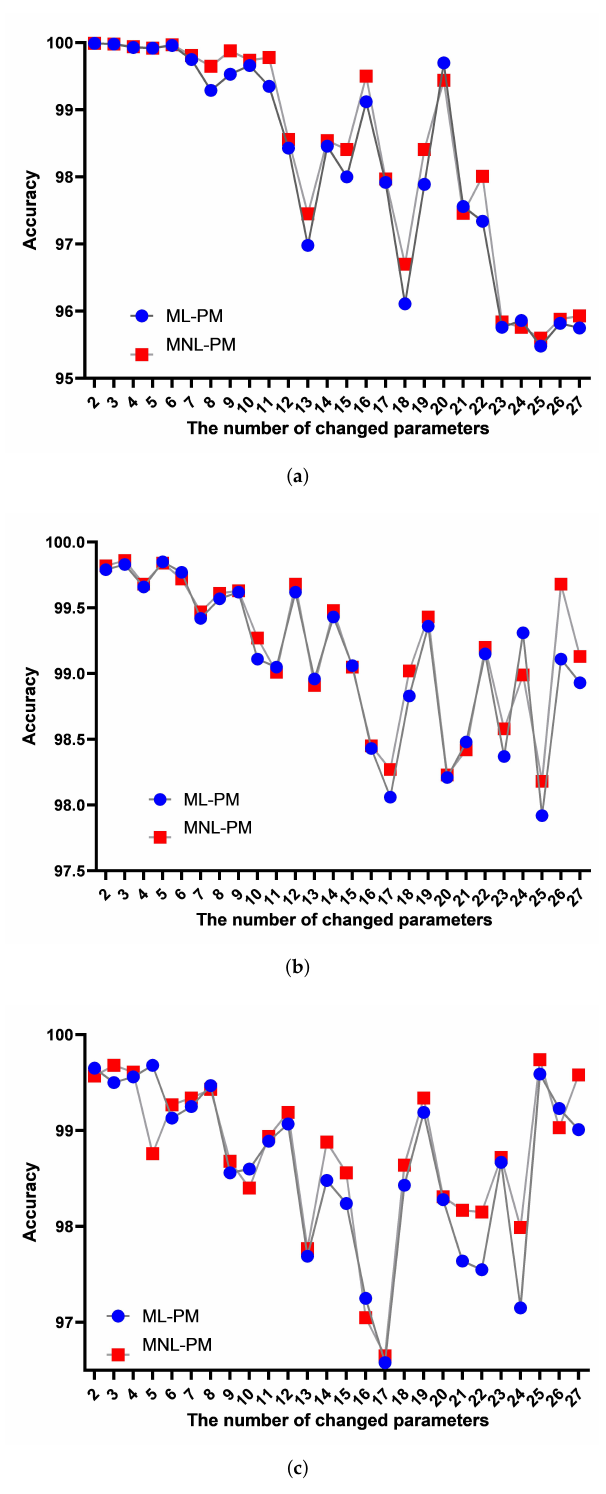
Figure 3. The performance on the PPA prediction with the different number of changed parameters. (( a ) for performance, ( b ) for power, and, ( c ) for